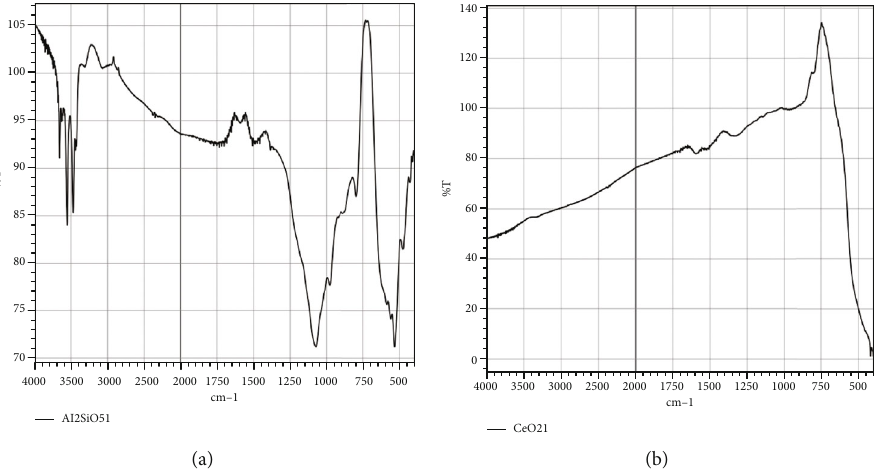
Figure 3: FTIR spectroscopy: (a) Al